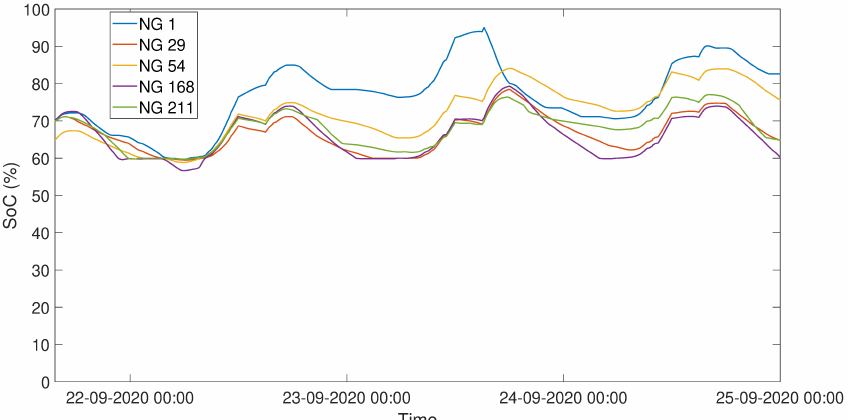
Figure 14. Evolution of the currents exchanged between the NGs with a 1500 Wh communal load— communal load operation.